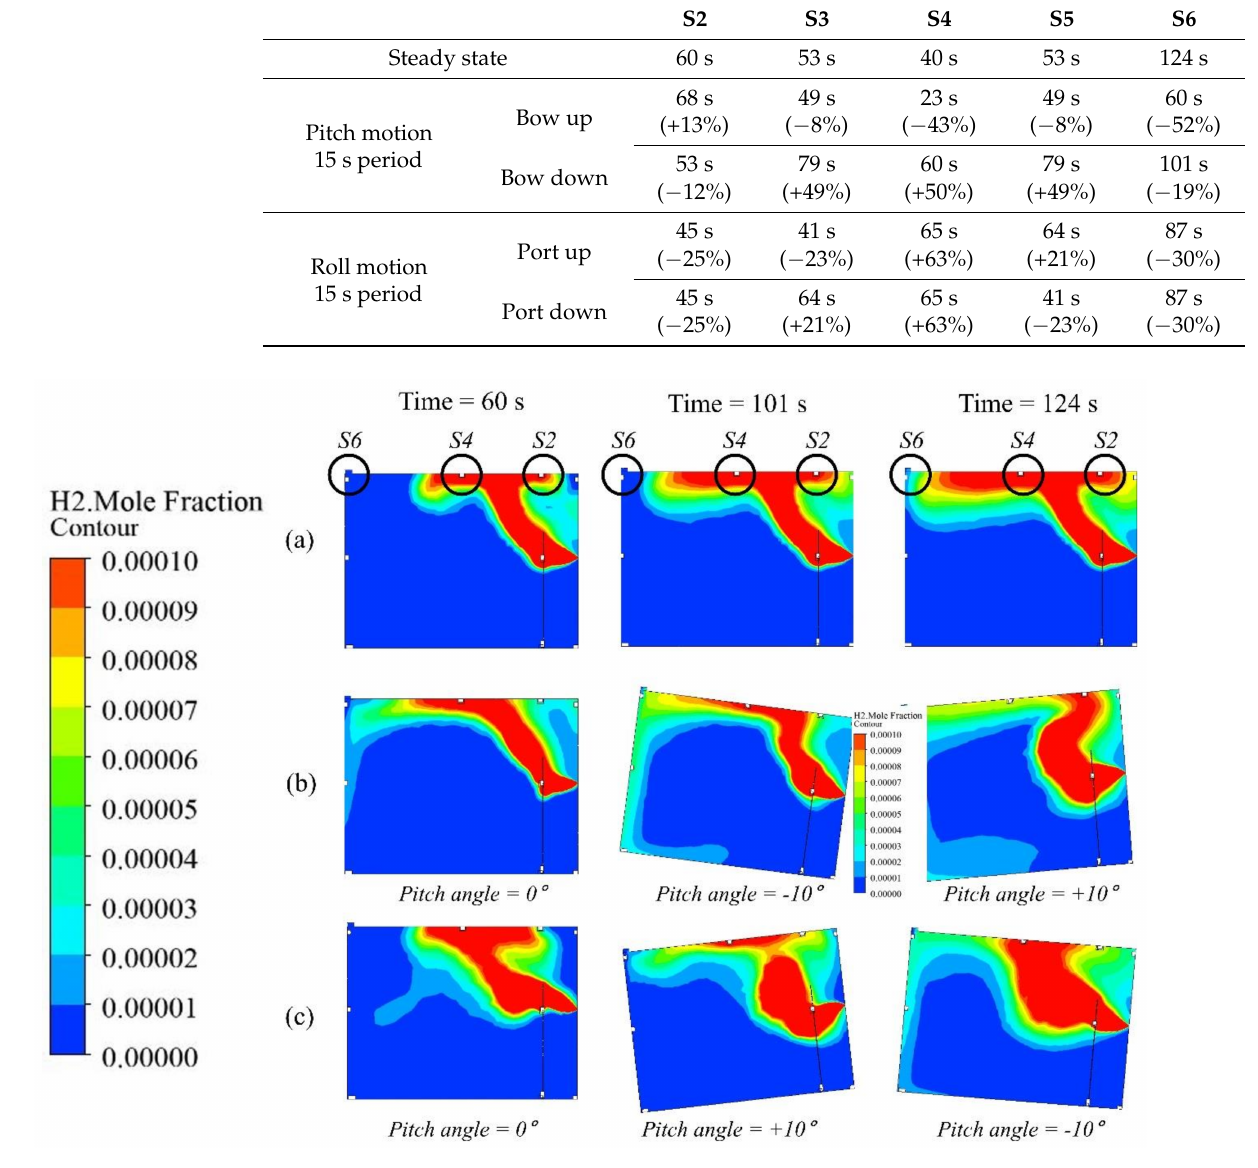
Table 5. Time for hydrogen to reach each sensor according to the ship motion directions.